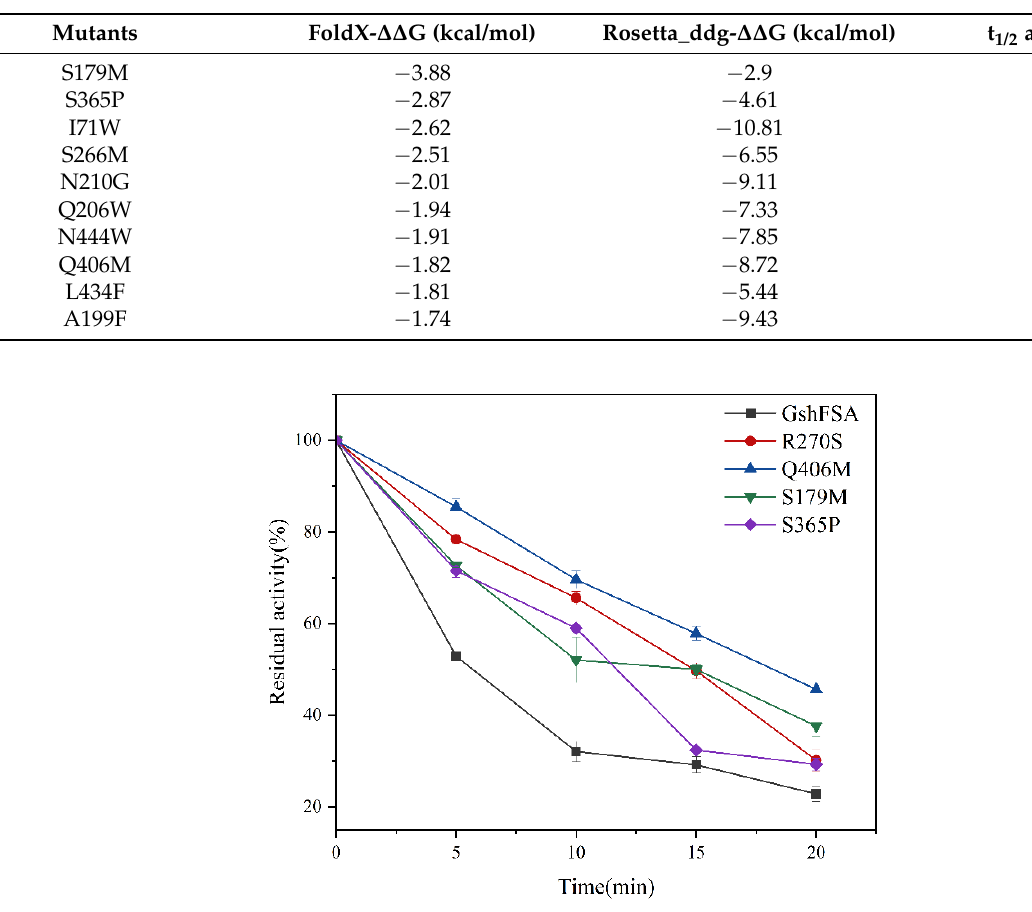
Table 2. Results of un/folding free energy calculation and half-life of mutants.